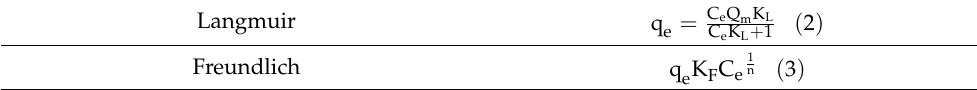
Table 1. Isotherm model